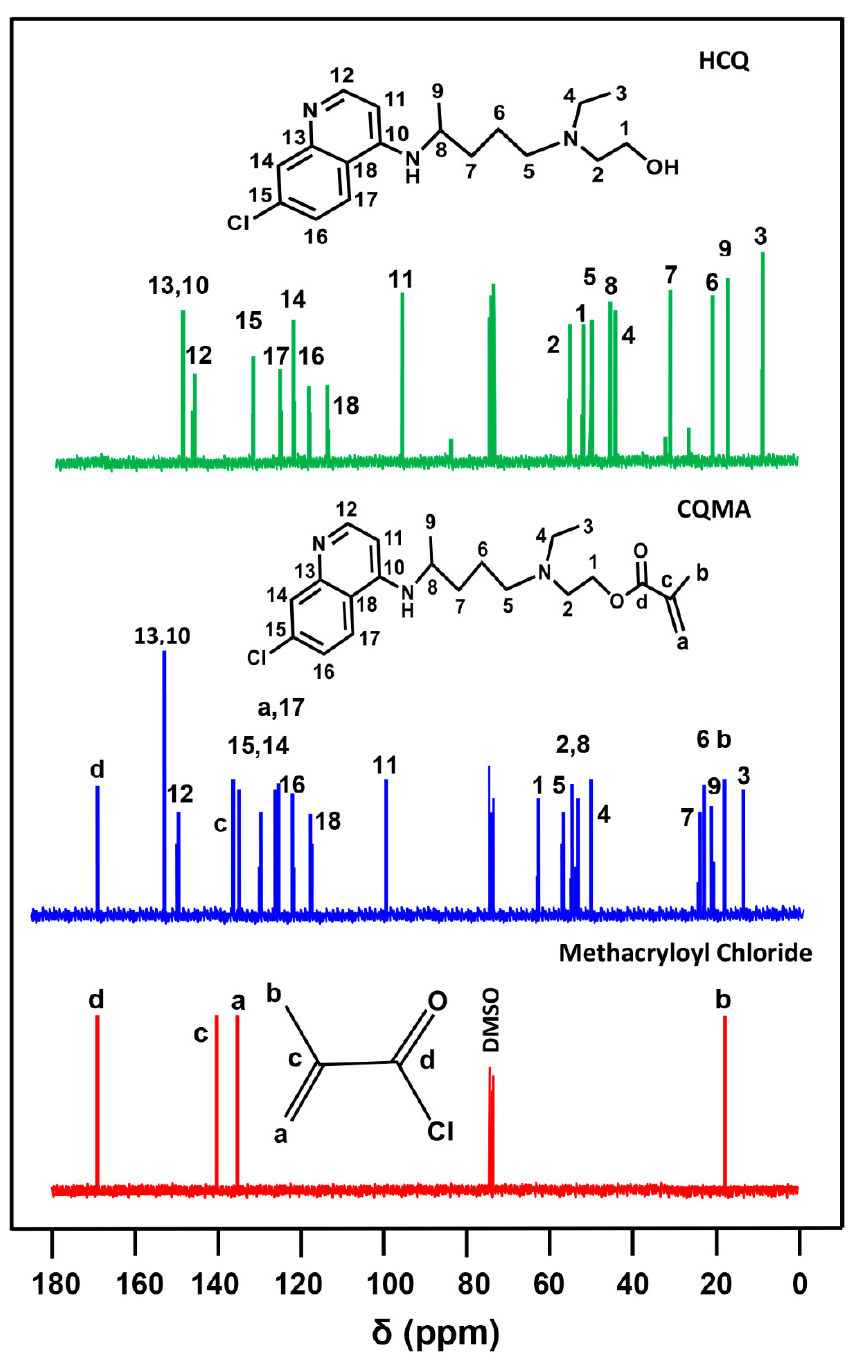
Figure 5. 13 C NMR spectra of pure HCQ, pure methacryloyl chloride and CQMA in DMSOd 6 .